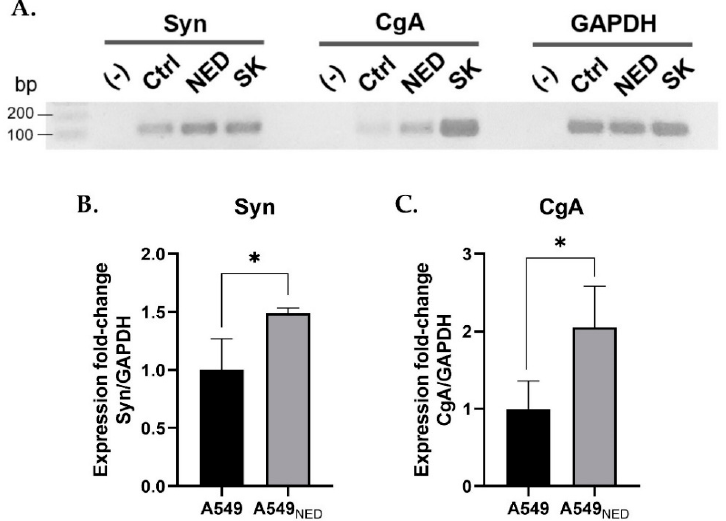
Figure 2. Gene expression of neuroendocrine markers. Syn, CgA, and GAPDH were amplified by RT-PCR from cDNA of A549 cells without treatment (Ctrl), A549 treated cells (NED), and neuroblastoma SK-N-AS cells (SK) as a positive control ( A ). Bar graphs showing changes in the relative gene expression of Syn ( B ) and CgA ( C ) in A549 cells with or without neuroendocrine differentiation (n = 3; * p < 0.05). 2.2. CD68 + Monocyte Levels Increase and CD4 + T Cells Decrease in Mice Immunized with A549 Cells, whereas Double Positive CD4 + CD8 + T Cells Increase in Mice Immunized with A549 NED Cells Cell populations within PBMCs were analyzed with flow cytometry. An antibody against CD68 was used to identify monocytes, a population of cells that establishes in the tissues as macrophages after circulating through the vasculature. Anti ‐ CD4 and anti ‐ CD8a antibodies were used to differentiate populations between helper and cytotoxic T cells, respectively. Finally, CD335 was used to identify NK cells—cytotoxic members of the innate immune system that play a pivotal role in protecting the body against cancer. The analysis showed that, in mice immunized with undifferentiated A549 cells, the percentage of circulating monocytes increased compared to the control group, while mon ‐ ocytes in mice immunized with A549 NED cells remained at baseline levels (Figure 3A). Sta ‐ tistical analysis showed that there was a significant difference between the groups ( p = 0.0045), while the mice immunized with PBS and A549 NED were statistically identical. In mice that were immunized with undifferentiated A549 cells, the percentage of CD4 + T lymphocytes decreased compared to the group immunized with A549 NED cells (Figure 3B). Statistical analysis showed a significant difference between the immunized groups ( p = 0.0217). Again, the data indicated that there was no statistically significant difference between the groups immunized with PBS and A549 NED cells. Unexpectedly, cytometric analyses targeting CD8a showed that, in both groups of immunized mice, the percentage of CD8 + T lymphocytes remained the same as in the con ‐ trol group (Figure 3C). Statistical analysis did not show differences between groups. In mice that were immunized with differentiated A549 NED cells, the percentage of CD4 + /CD8 + double ‐ positive T lymphocytes increased compared to the control group in ‐ jected with PBS (Figure 3D). Statistical analysis showed a quasi ‐ significant difference be ‐ tween the A549 NED and PBS groups ( p = 0.0988), whereas the data indicated that there was no significant difference between the PBS and A549 groups. Finally, mice that were immunized with either undifferentiated or neuroendocrine A549 cells had more circulating NK cells compared to the control group (Figure 3E). The